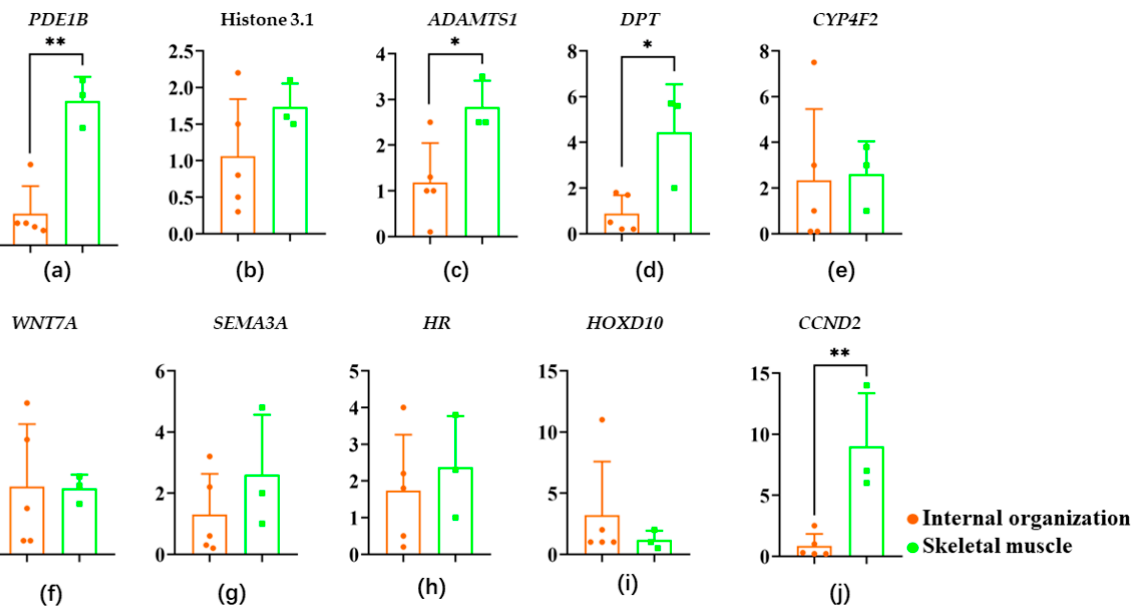
Figure 7. Verification of differentially expressed genes by qRT-PCR compared with beta-actin. ( a ) upregulation of gene expression levels. ( b ) downregulation of gene expression levels. ** p < 0.01.